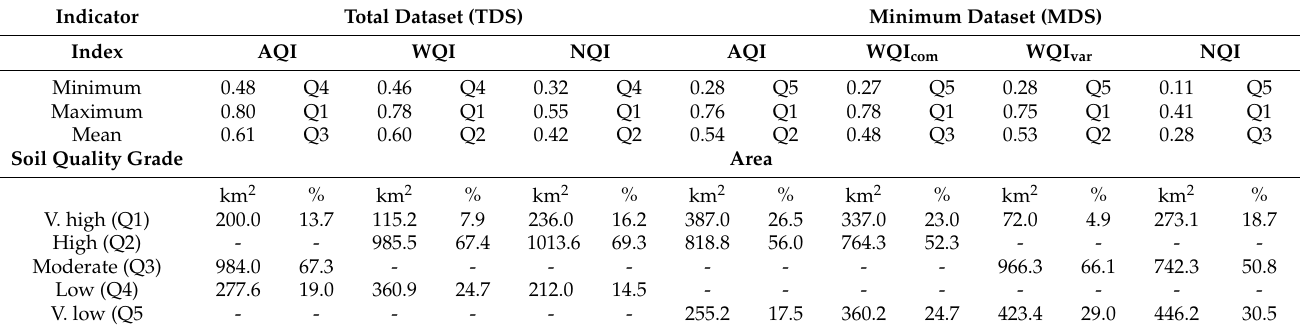
Table 6. Minimum, maximum, mean, and grades of soil quality indices using two indicator approaches. Indicator Total Dataset (TDS) Minimum Dataset (MDS)